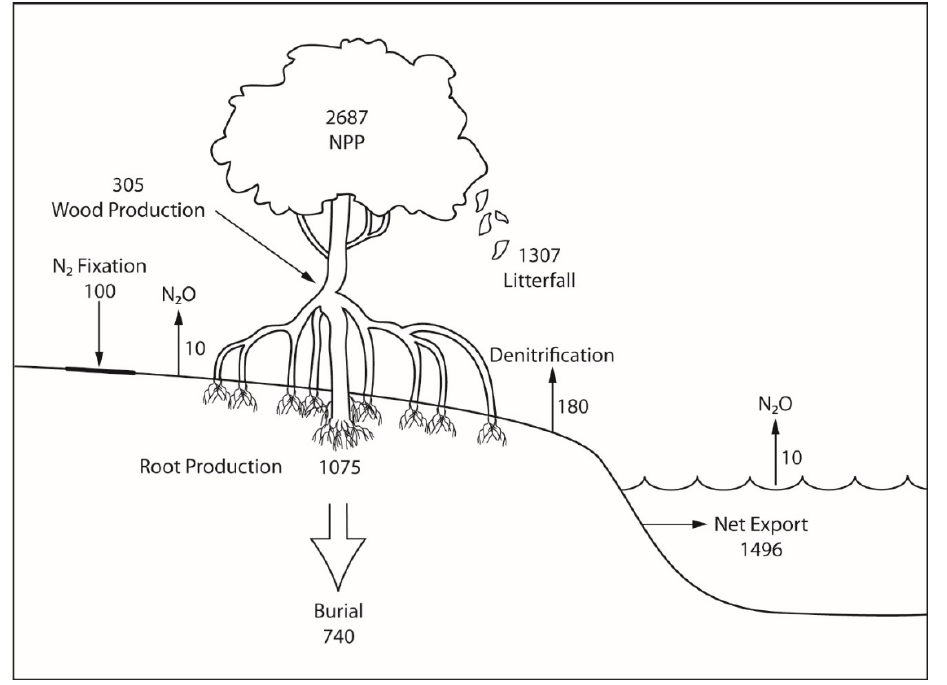
Figure 1. Nitrogen mass balance for the world’s mangrove ecosystems. Units are Gg N year − 1 . NPP = net primary production. The model assumes a global mangrove area of 152,000 km 2 [2]. Data modified from Alongi [19].